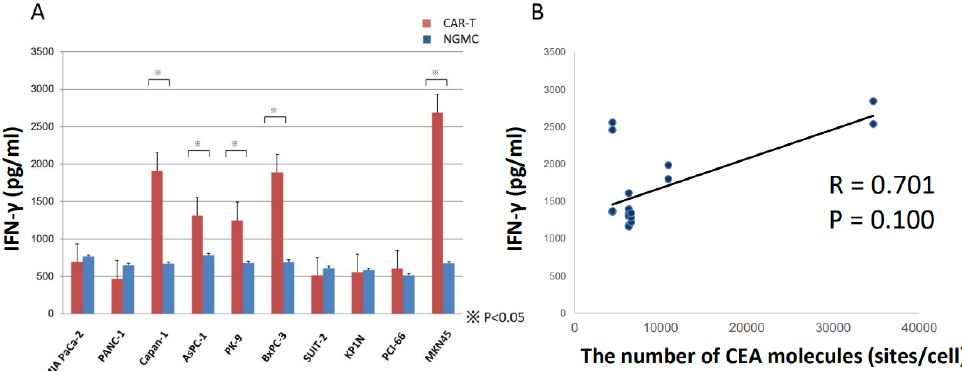
Figure 3. In vitro functional assays: ELISA. ( A ) Quantitative measurement of IFN- γ in cell super- natant after co-culture with CAR-T. ( B ) The secretion levels of IFN- γ were correlated with the number of CEA molecules. ※ p < 0.05.